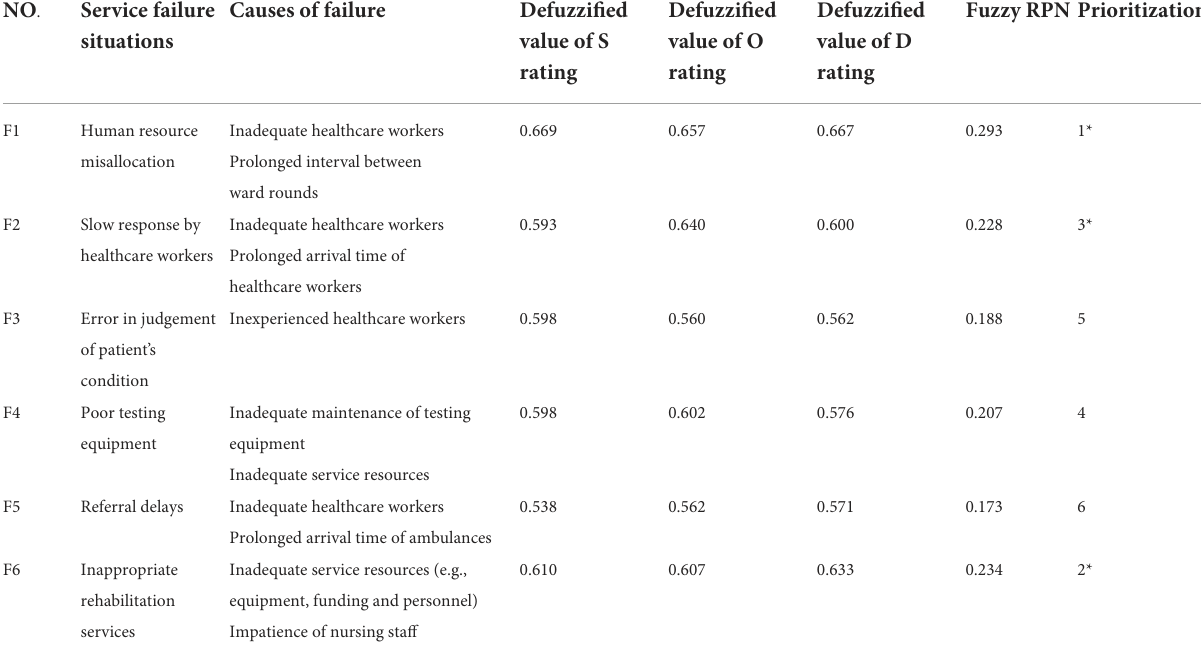
TABLE 9 Analysis of the causes of failures in the CMEC service model for the